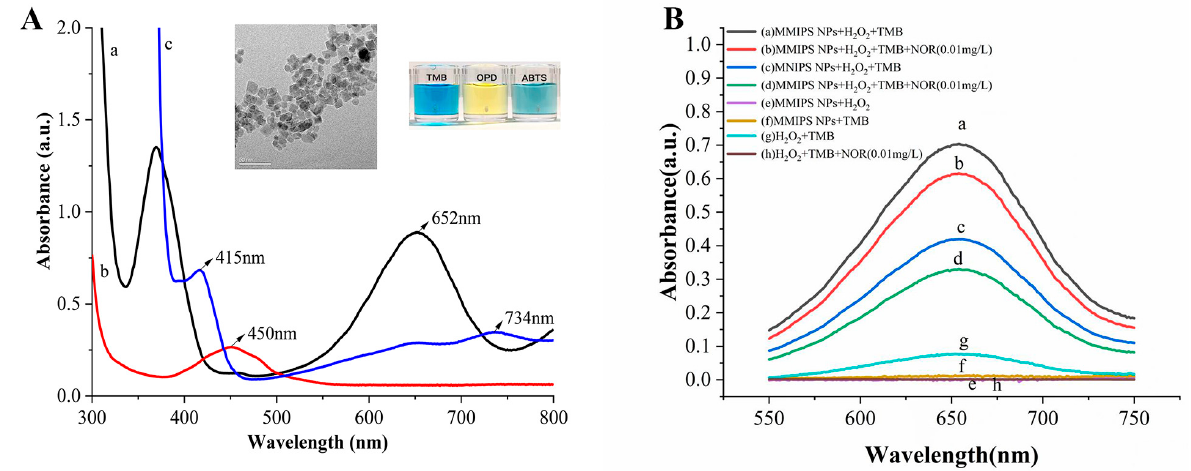
Figure 1. Detection feasibility of Fe 3 O 4 MMIP NPs for NOR. ( A ) Absorption spectra of the reactions of different chromogenic substrates, a: TMB, b: OPD, and c: ABTS. ( B ) Absorption spectra of different reaction systems a: Fe 3 O 4 MMIP NPs + H 2 O 2 + TMB, b: Fe 3 O 4 MMIP NPs + H 2 O 2 + TMB + 0.01 mg/mL NOR, c: Fe 3 O 4 MMIP NPs + H 2 O 2 + TMB, d: Fe 3 O 4 MMIP NPs + H 2 O 2 + TMB + 0.01 mg/mL NOR, e: Fe 3 O 4 MMIP NPs + H 2 O 2 , f: Fe 3 O 4 MMIP NPs + TMB, g: H 2 O 2 + TMB, h: H 2 O 2 + TMB + 0.01 mg/mL NOR. All trials were repeated 3 times.